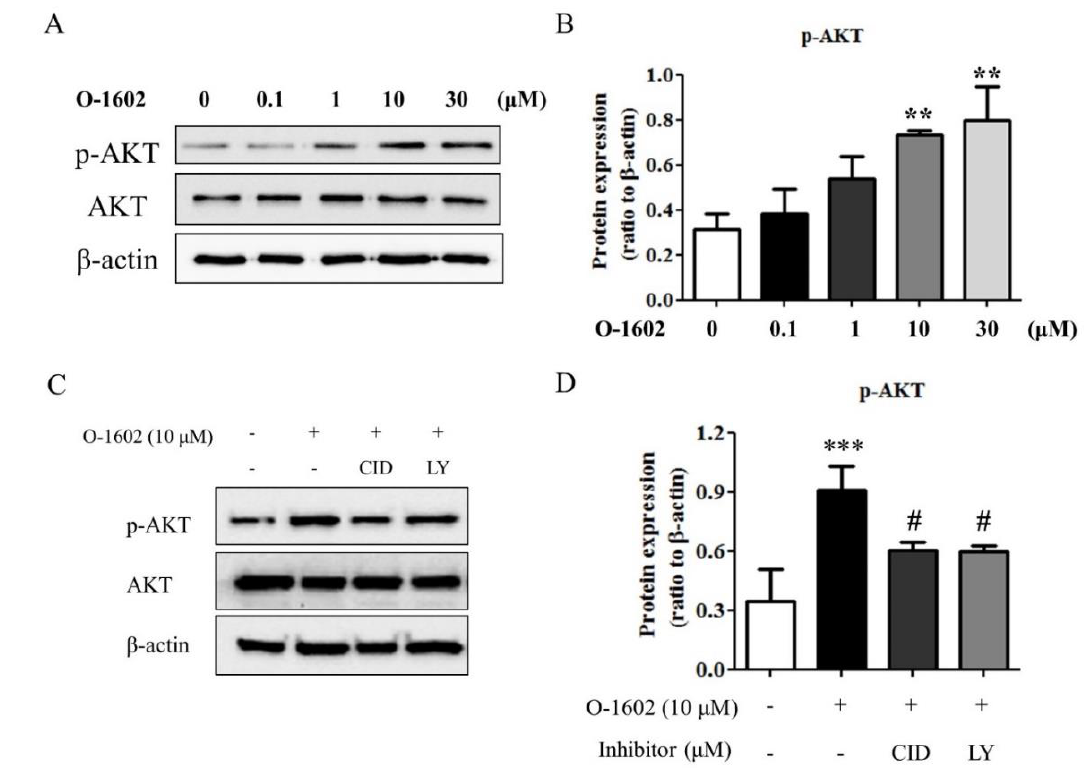
Figure 4. O-1602 induces activation of Akt through GPR55 and PI3K. Hep3B cells were treated with different concentrations of O-1602 for 48 h. Western blotting analysis was performed for Akt and phospho-Akt (S347) in Hep3B cells. ( A ) Representative blots of phospho-Akt, Akt, and β -actin. ( B ) Quantitative western blot analysis of phospho-Akt. Hep3B cells were pretreated with CID16020046 or LY294002 for 30 min and then treated with 10 µ M O-1602 for 48 h. ( C ) Representative blots of phospho-Akt, Akt, and β -actin. ( D ) Quantitative western blot analysis of phospho-Akt. Data are from three individual experiments and expressed as mean ± SD. ** p < 0.01, *** p < 0.001, compared with the non-treated group; # p < 0.05, compared with O-1602-treated group.